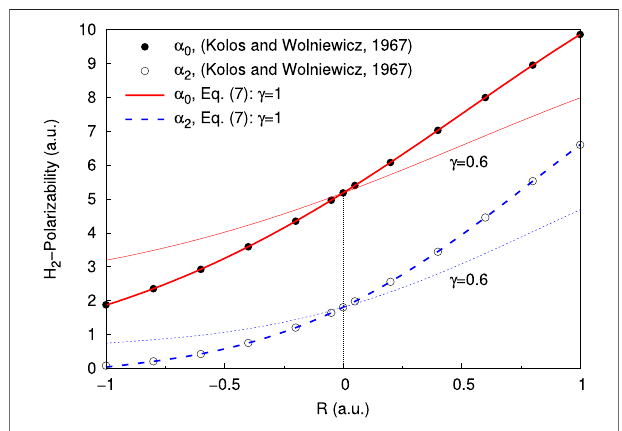
FIGURE 1 | (Color online) Isotropic ( α 0 ) and anisotropic ( α 2 ) dipole polarizabilities for the hydrogen molecule, as a function of the internuclear separation. The thick solid and dashed lines represents the fi ts of Eq. 7 with γ =1, to the ab initio data. The same curves for γ =0.6 are shown in thin lines (see text for